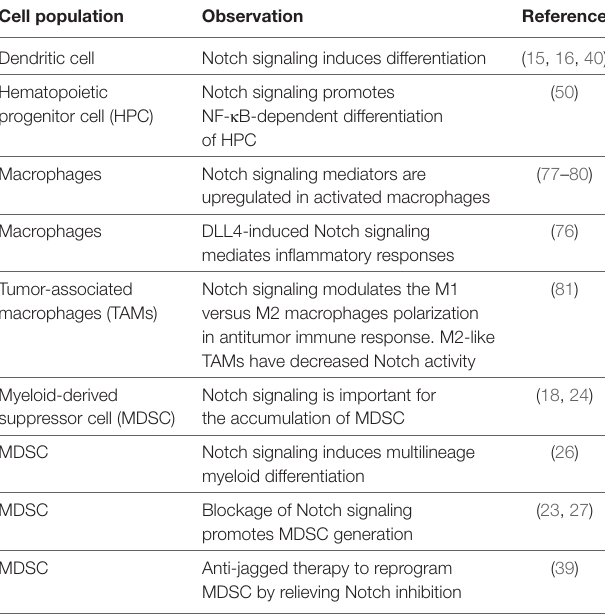
TAble 1 | Notch effects in the differentiation and function of tumor-associated myeloid